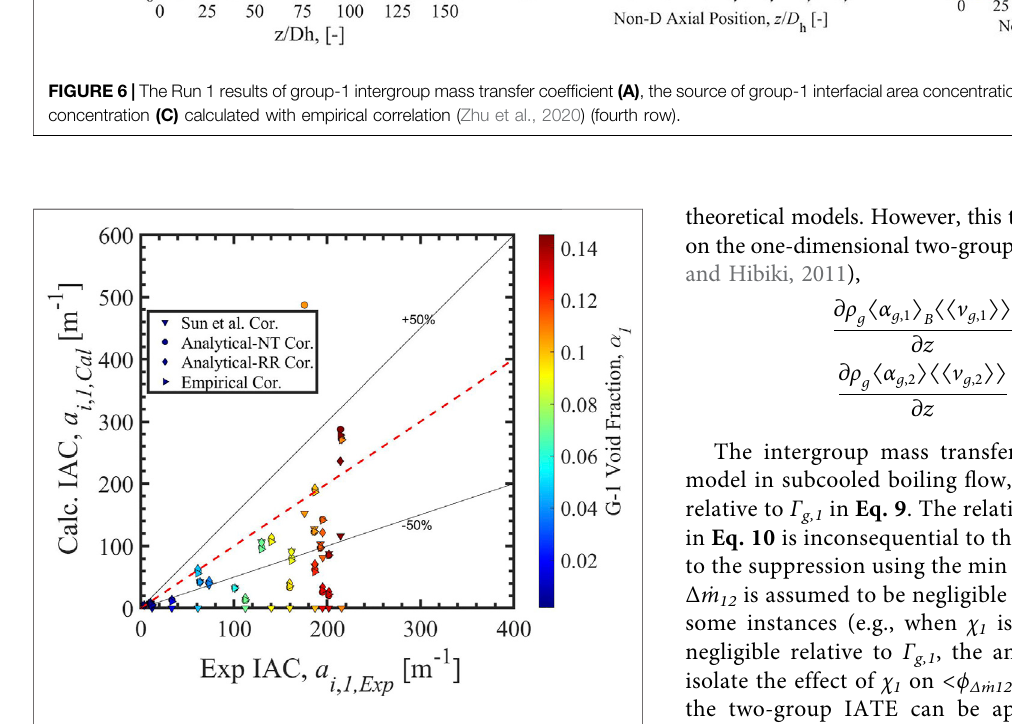
FIGURE 7 | The a i,1 benchmark of 2-G IATE using four group-1 intergroup mass transfer coef fi cient correlations.